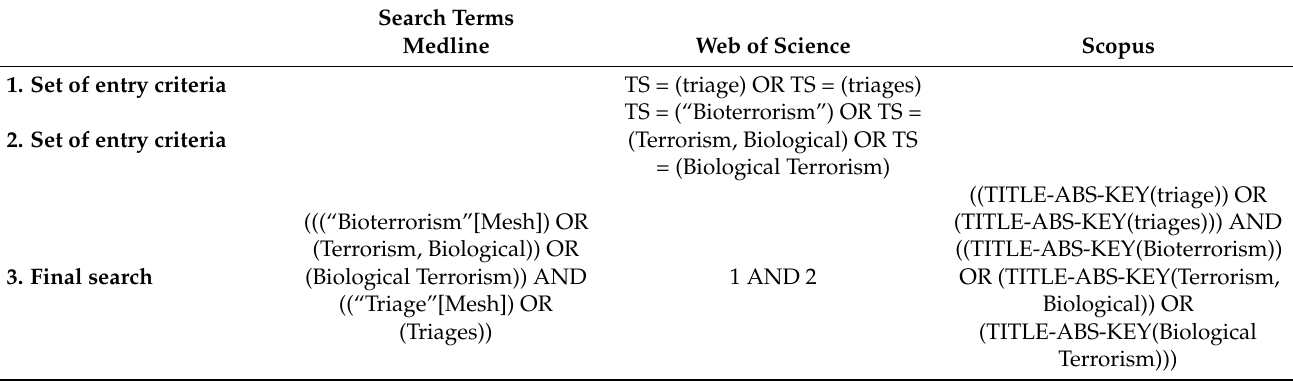
Table 1. Systematic search